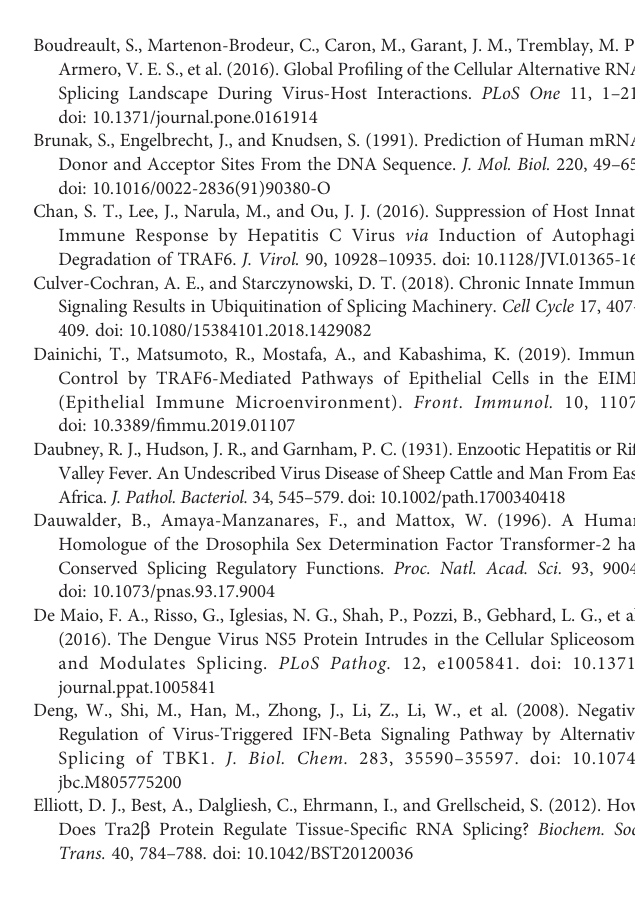
Supplementary Figure 1 | HEK293 cells were infected with RVFV at MOI = 1 for the times indicated, then cells were lysed and visualized by western blot (see Materials and Methods